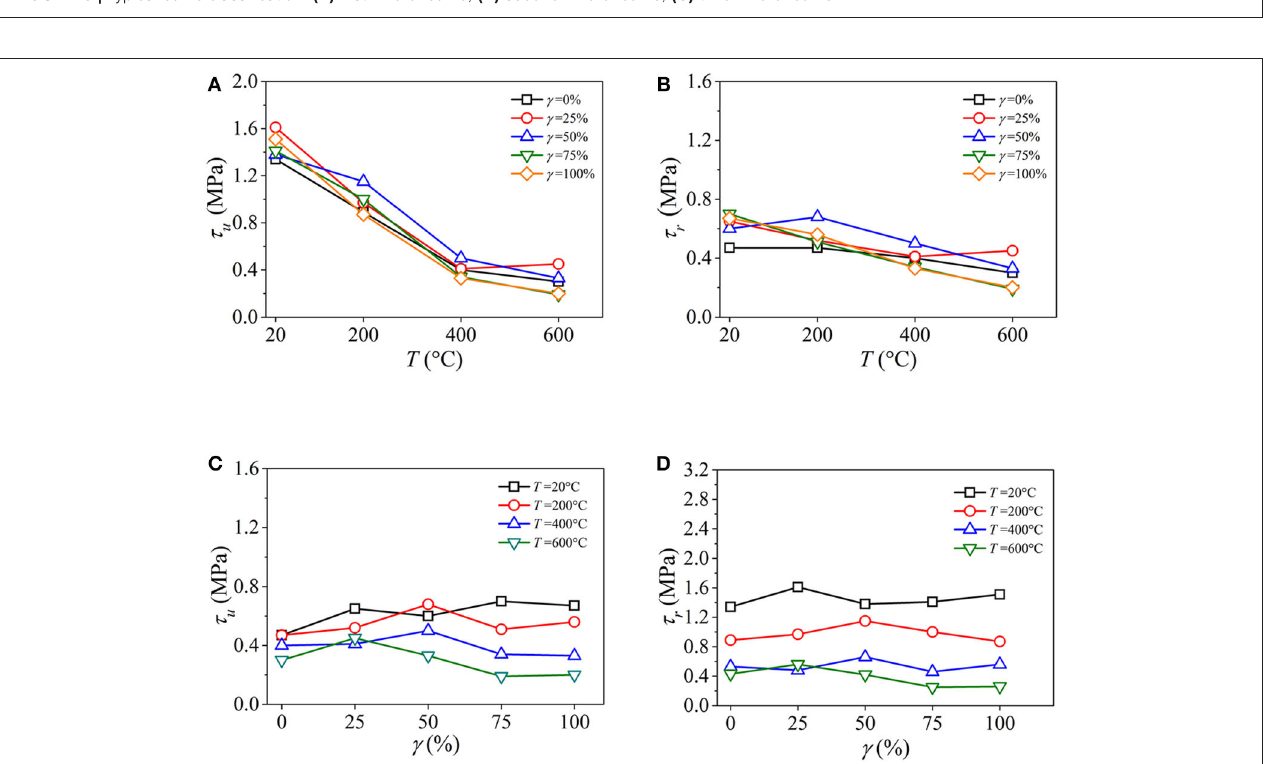
FIGURE 9 | Effect of different parameters on bond strength: (A) change of ultimate bond strength with maximum temperature; (B) change of residual bond strength with maximum temperature; (C) change of ultimate bond strength with replacement percentage; (D) change of residual bond strength with replacement percentage.